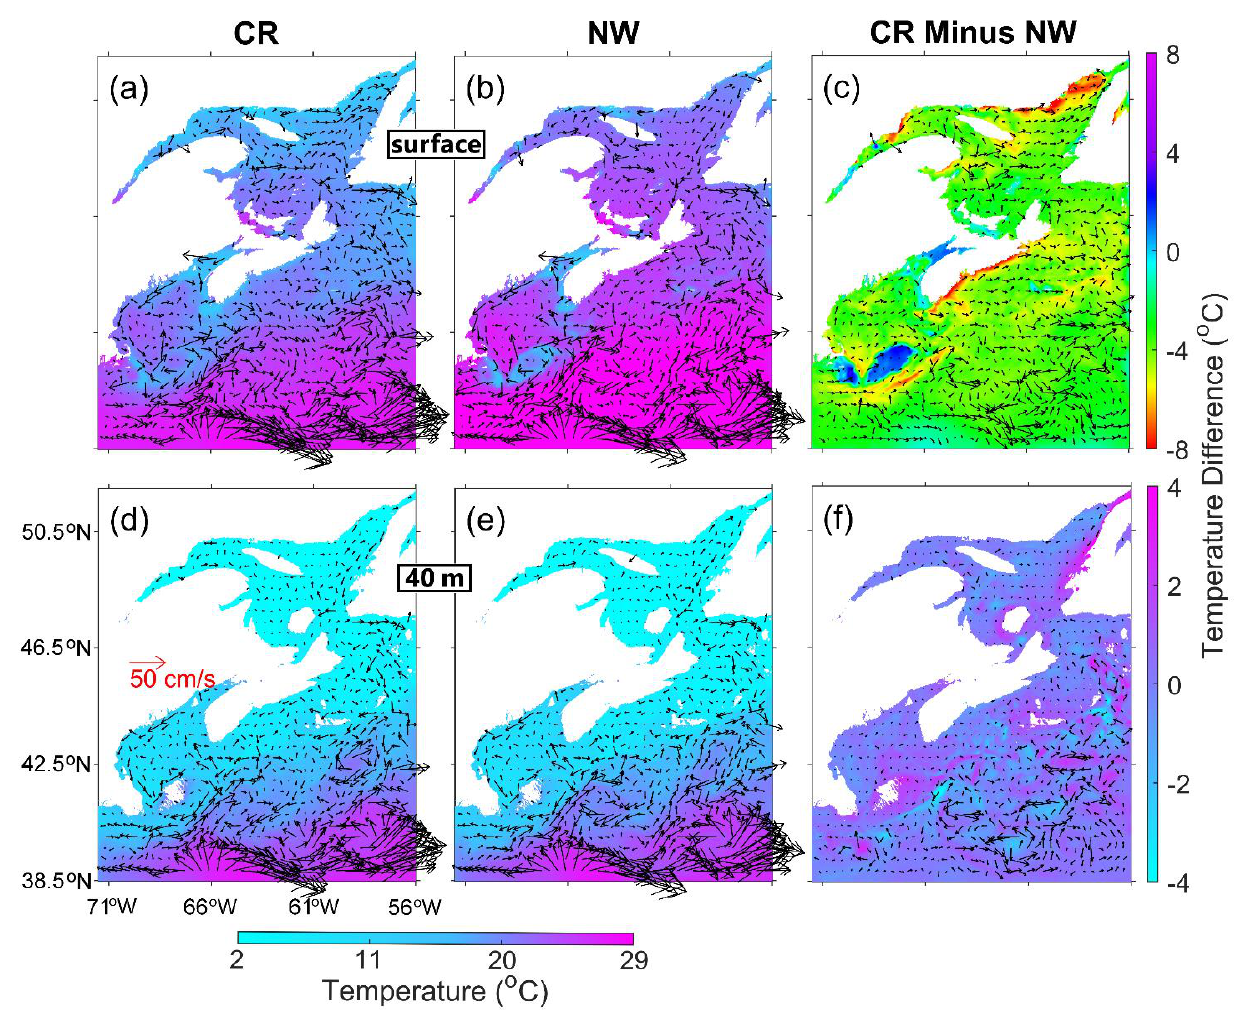
Figure 9. Monthly-mean currents and temperature in August 2018 produced by submodel L2 at ( a , b ) the sea surface and ( d , e ) 40 m over the L2 domain in cases ( a , d ) CR and ( b , e ) NW. Differences in the monthly-mean currents and temperature between cases CR and NW at ( c ) the sea surface and ( f ) 40 m. For clarity, velocity vectors are plotted at every 14th model grid point.